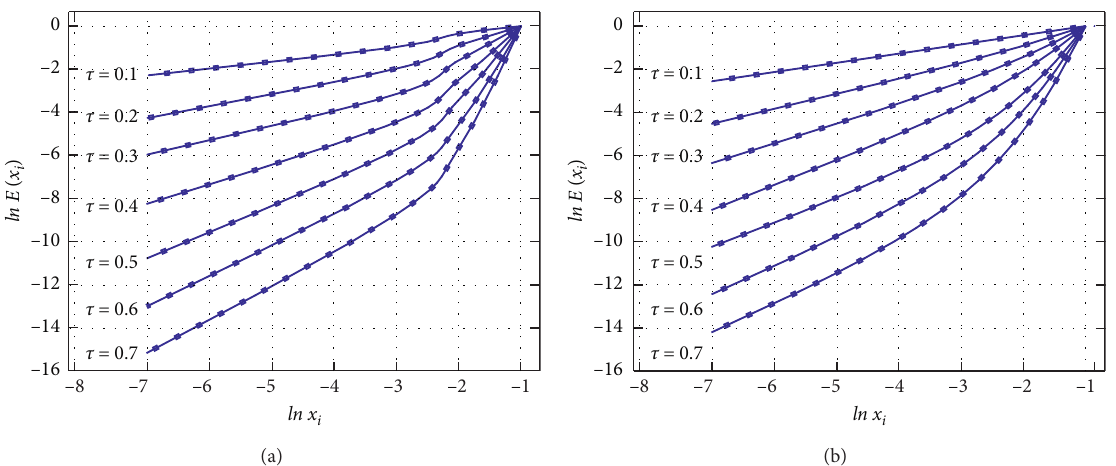
Figure 5: Relationship between ln E ( x i ) and ln x i when the variable is true value (a) and predicted value (b) with different corresponding output variables ( τ